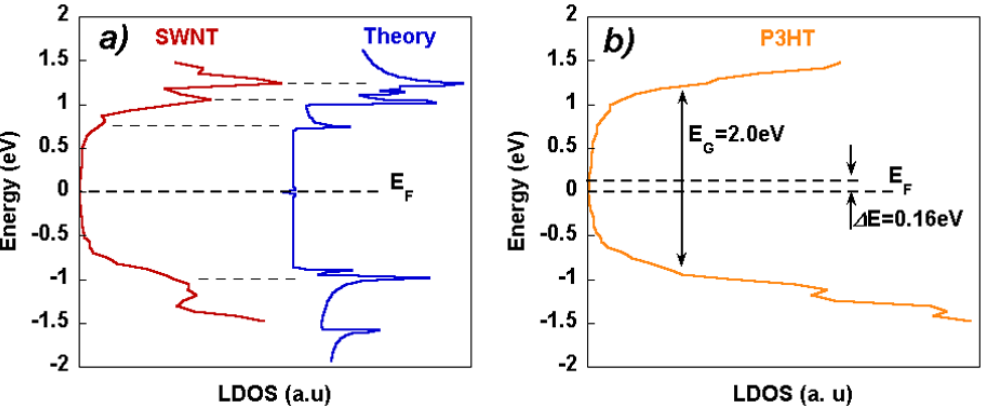
Figure 7. (a) Scanning Tunneling Spectroscopy spectrum of the bare nanotube section. The agreement between the experimental result and the theoretical curve is evident and confirmed by the coincidence of the Van Hove singularities. (b) Differential conductance related to the local density of states (LDOS) of the P3HT covered part of the nanotube. The shift of the energy gap towards the highest occupied molecular orbital (HOMO) is due to a charge transfer from the polymer to the